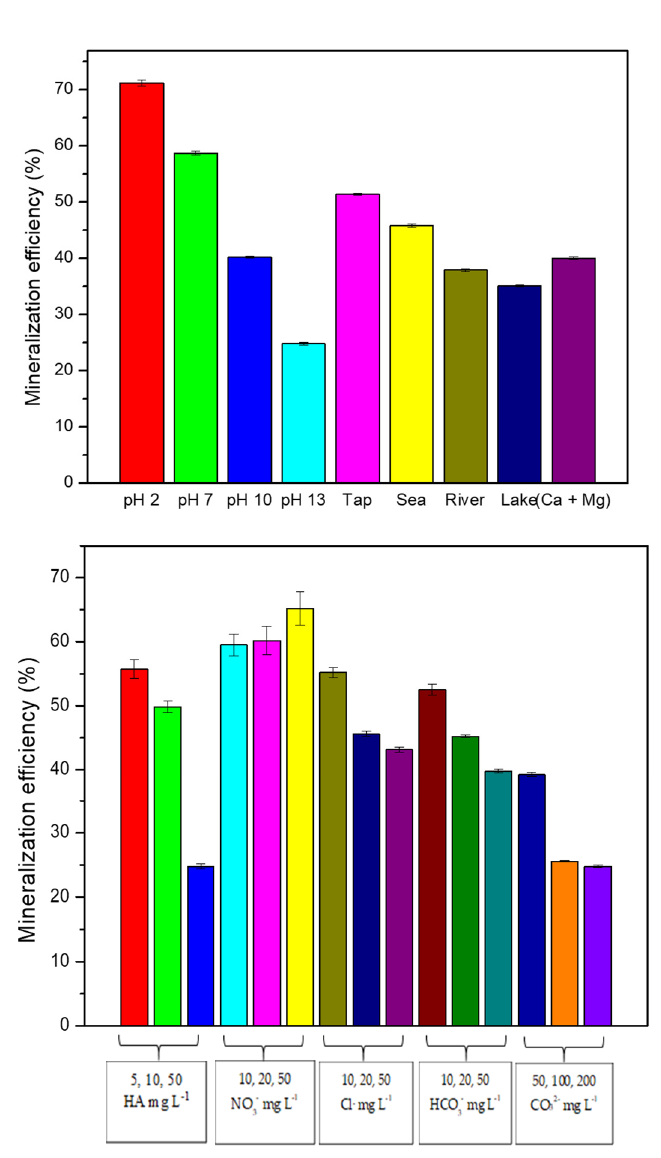
Figure 5. Mineralization e ffi ciency of 5 mg L − 1 carbamazepine under di ff erent conditions.